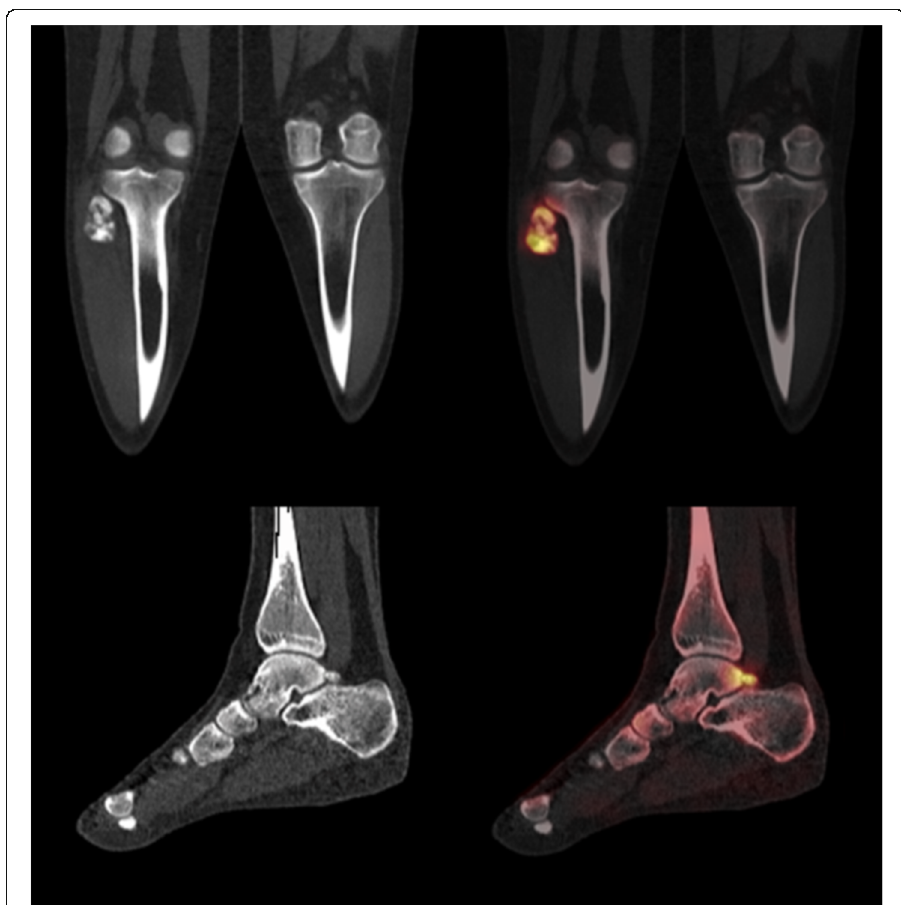
Fig. 6 Images of an 18-year-old male ’ s right leg produced with xSPECT Quant ™ and xSPECT Bone ™ (Siemens Healthineers), containing a giant cell tumour in the proximal fibula. Uptake in proximal tibio-fibular joint was concluded as normal as it was mild and reactive and no erosion could be seen. Siemens claim that xSPECT Bone ™ offers improved image quality and lesion localisation through sharper edge delineation. But is there enough evidence to assume it can be routinely called upon to perform accurate and reproducible quantification to support important clinical decisions? (Images courtesy of Siemens Healthineers, Erlangen,